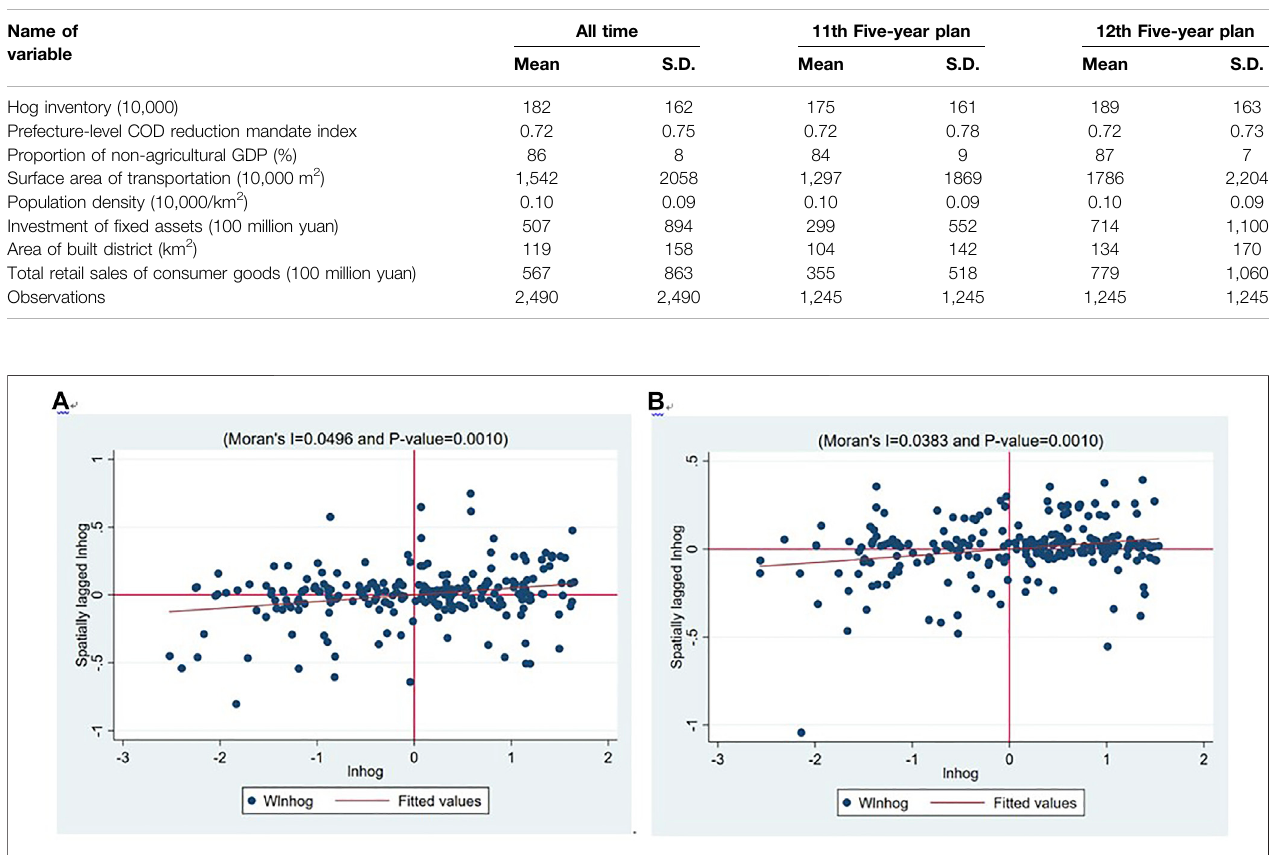
TABLE 1 | Summary statistics.